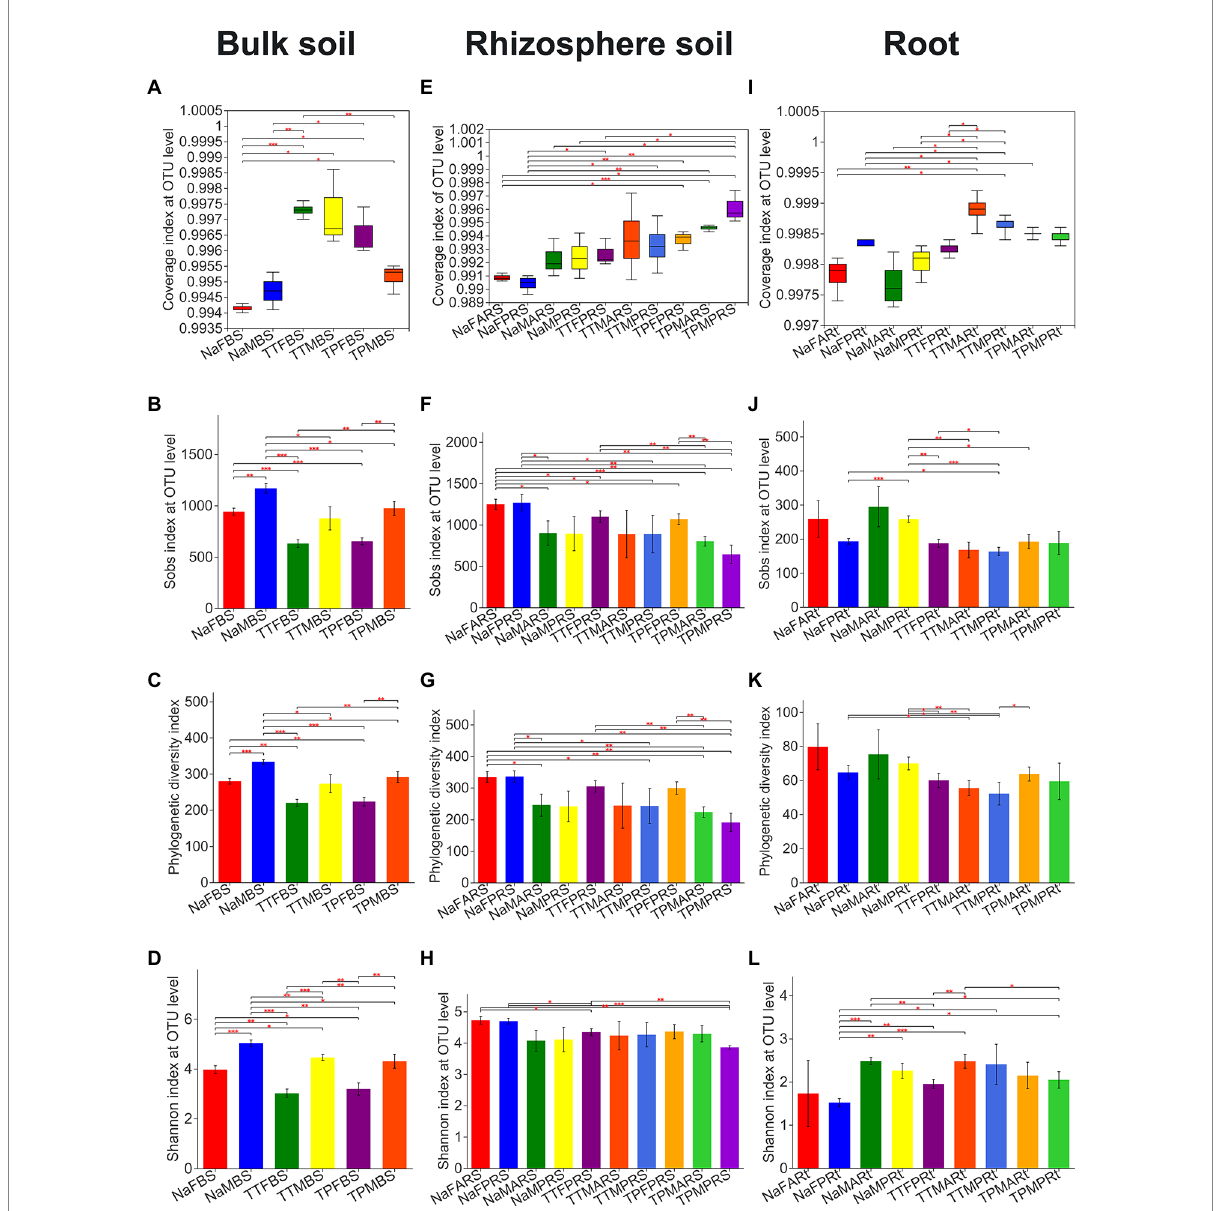
FIGURE 1 Observed OTU richness (Sobs), phylogenetic diversity, Shannon evenness and Good’s coverage (Coverage) indices for fungal microbiota across different compartments of 3 sorghum lines. A - D , E - H , and I - L reprent Coverage, Sobs, PD, and Shannon indices of bulk soil , rhizosphere soil, and root compartents,respectively. Statistical differences between pairwise groups were determined by using Welch’s t -test. *,** and *** indicate p < 0.05, p < 0.01 and p < 0.001, respectively. For the group name, Na, TT and TP refer to the perennial sweet sorghum NaPBS778 and the control lines TP213 and TP60, respectively; F and M refer to the blooming stage and the maturity stage, respectively; A and P represent the latest aerial roots and the primary roots, respectively; BS, RS, and Rt represent bulk soil, rhizospheric soil and roots,